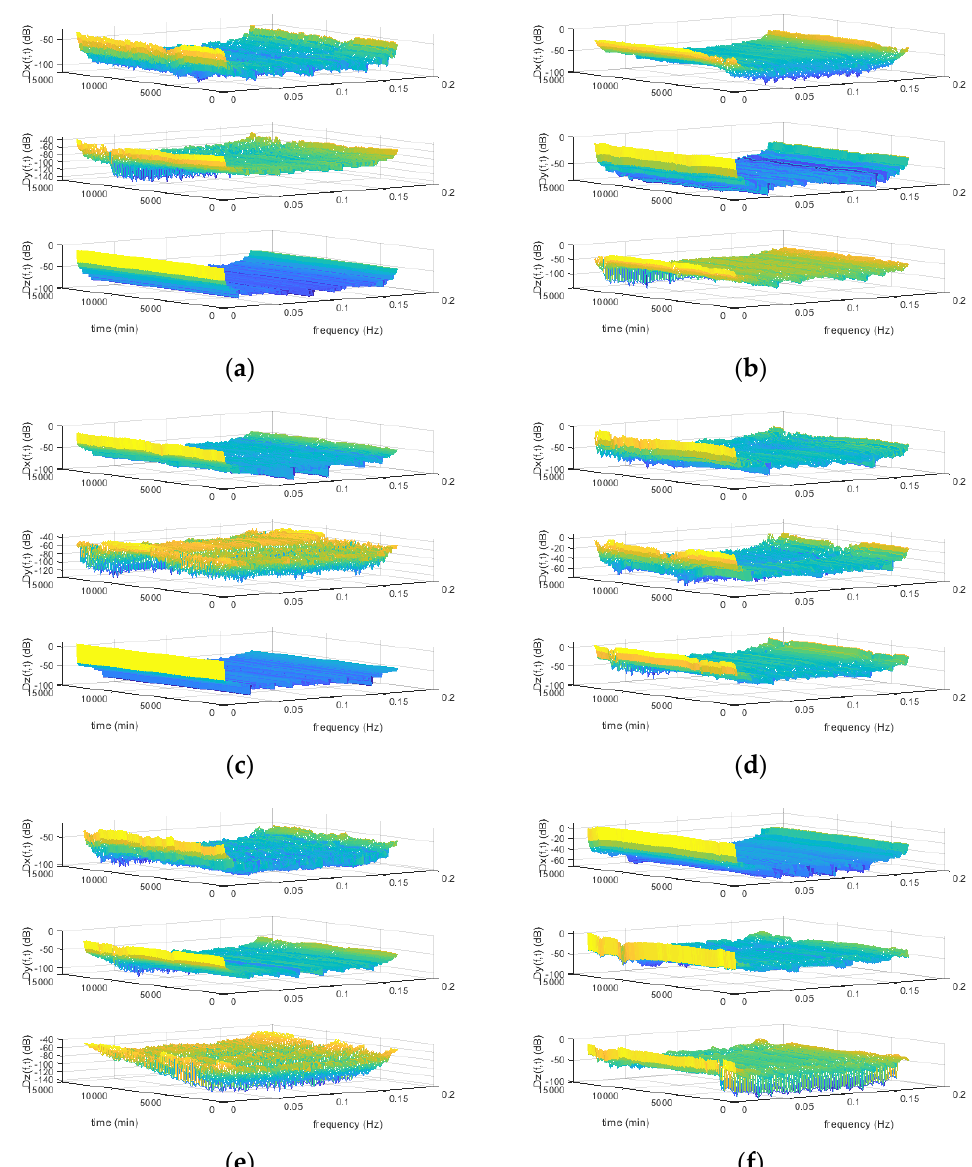
Figure 4. Dynamic power spectrum of the magnitude of each component of the magnetic